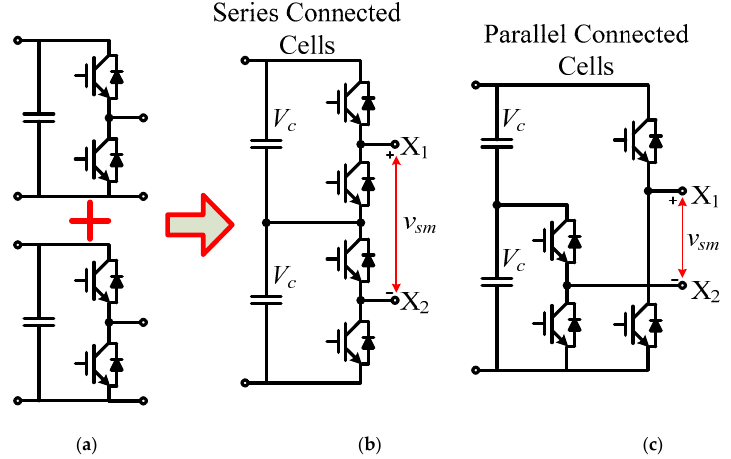
Figure 16. Structures of basic cell. ( a ) 2L HBSM, ( b ) 3L FBSM, ( c ) 3L TMSM, ( d ) 3L NPCSM, ( e ) 3L FCSM, ( f ) 3L ANPCSM.